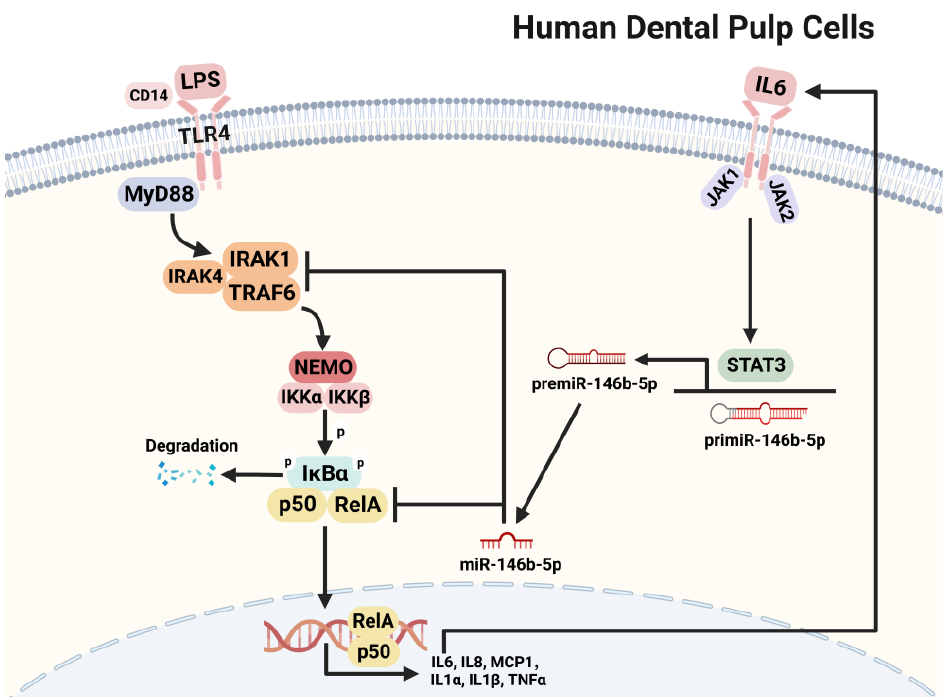
Figure 7. A schematic graph illustrating the role of miR-146b-5p in LPS-stimulated hDPCs. LPS binds to TLR4 thus activating the NF-κB signaling pathway and resulting in the synthesis of pro-inflammatory cytokines IL6, IL8, MCP1, IL1α, IL1β, and TNFα. Generally, IL6 further initiates JAK/STAT3 signaling, which is responsible to generate mature miR-146b-5p. miR-146b-5p, in turn, negatively regulates the NF-κB signaling pathway by targeting TRAF6, IRAK1, and RELA. The same phenomena were confirmed in LPS-applied rat dental pulp tissues ex vivo. Created with BioRender.com.